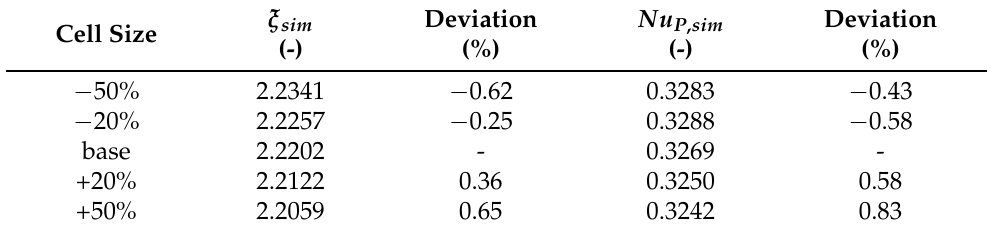
Table A2. Cell size study of synthetic cluster